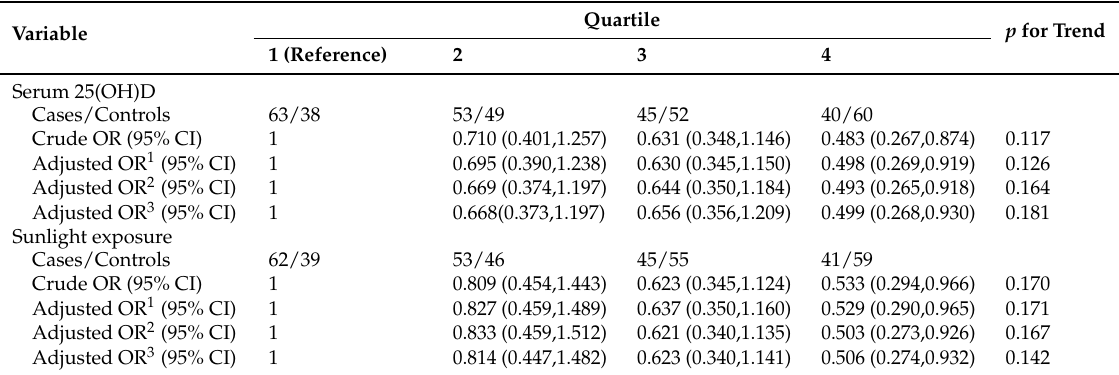
Table 2. Odds ratios (ORs) and 95% confidence intervals (CIs) for Parkinson’s disease by quartiles of serum vitamin D intake and sunlight